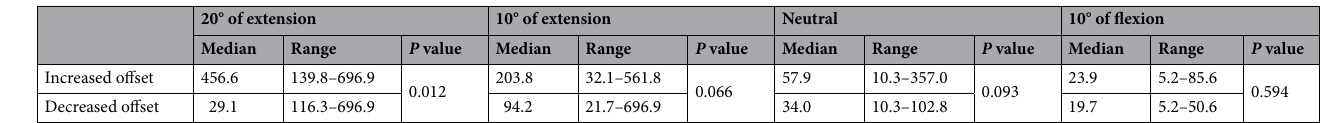
Table 5. Maximum surface pressure (kPa) of the iliopsoas muscle when stem offset was changed. Values are shown as the median and range. The Wilcoxon signed-rank test was used for comparisons between stem offset values.